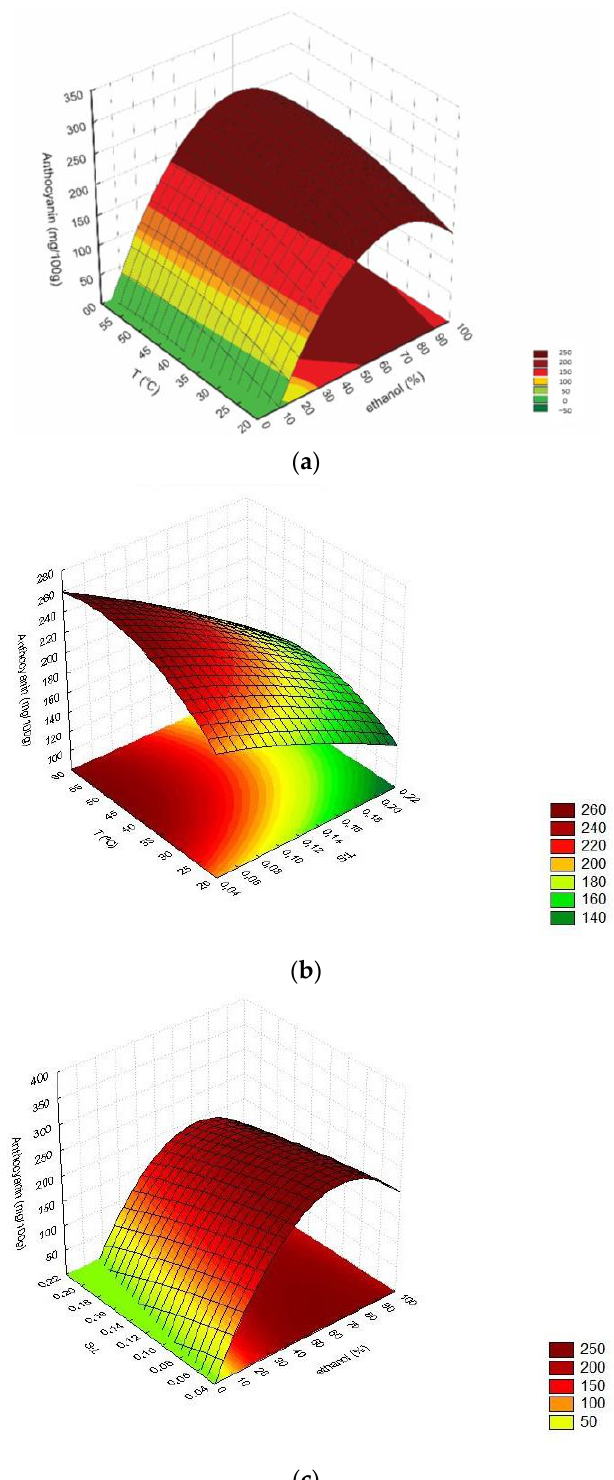
Figure 1. Response surfaces for total monomeric anthocyanins content: ( a ) Ethanol (%) × Temperature ( ◦ C) for S:L of 1:10; ( b ) S:L ratio × Temperature ( ◦ C) for ethanol concentration of 50%; ( c ) S:L ratio × Ethanol (%) for a temperature of 40 ◦